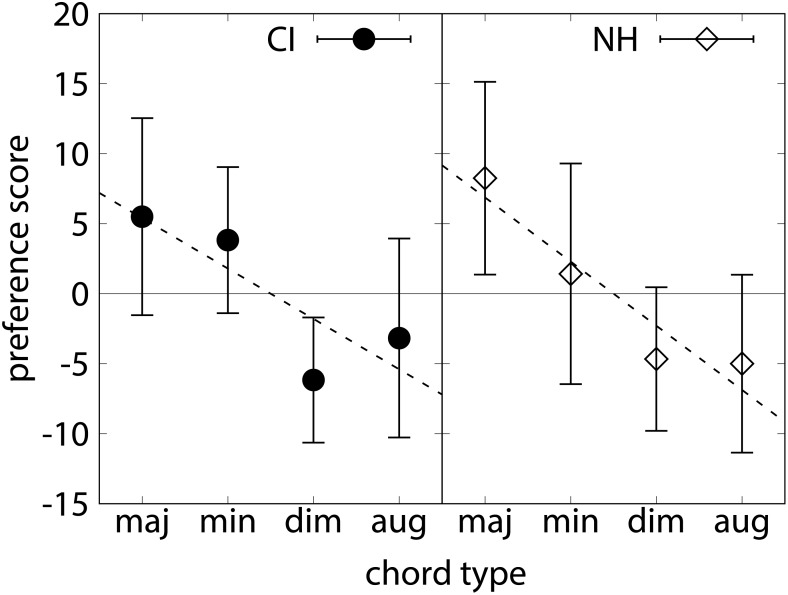
Mean preference scores of the different chord types in experiment 2 (chord preference task), CI listeners (left panel) and NH listeners (right panel). Error bars indicate standard deviation.